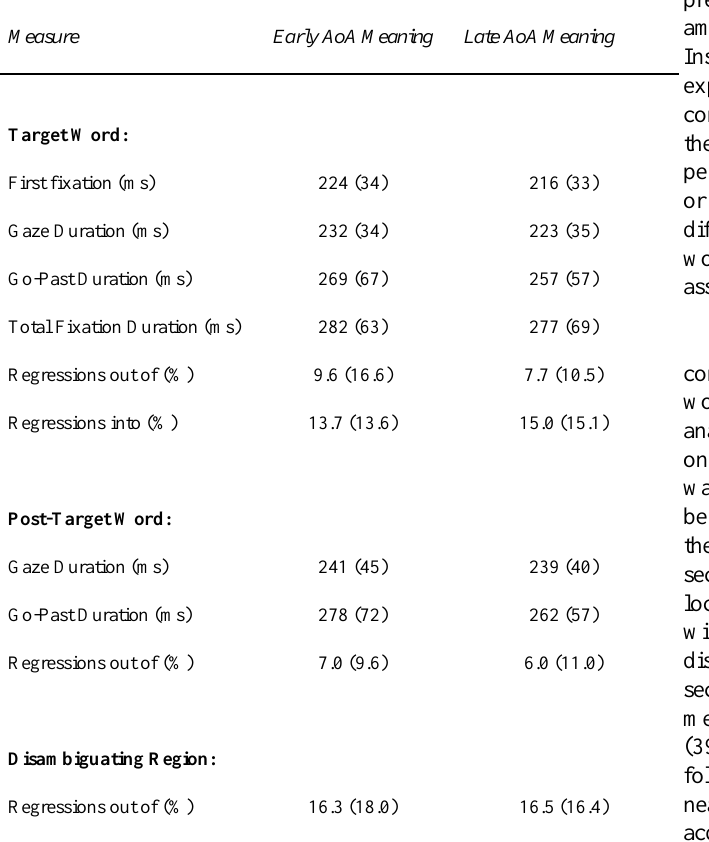
Participant means for Experiment